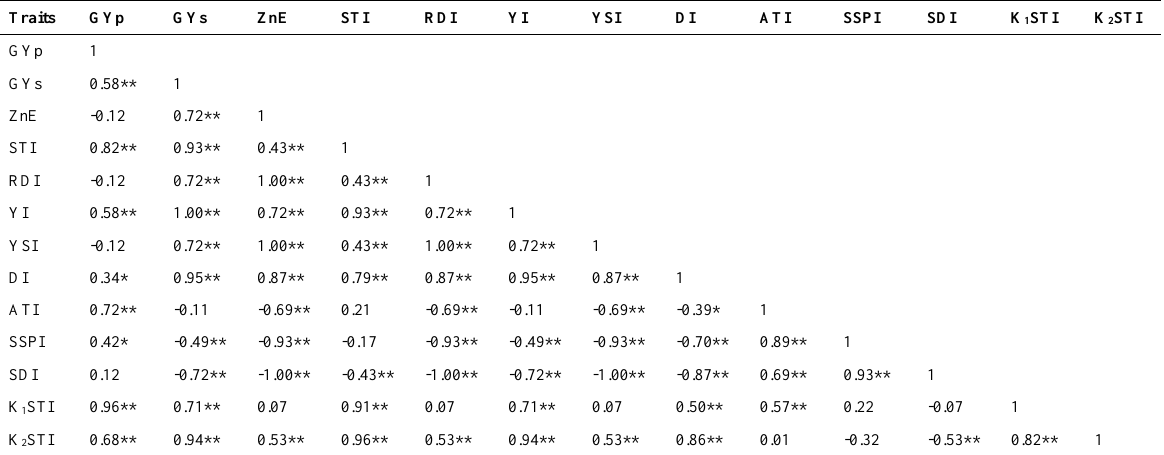
Table 6. Correlation coefficients between zinc stress tolerance indices and grain yield in normal and zinc-deficient stress conditions.